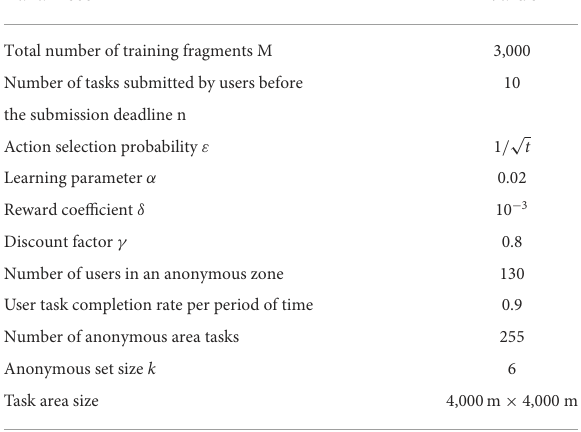
TABLE 5 Experimental parameters.